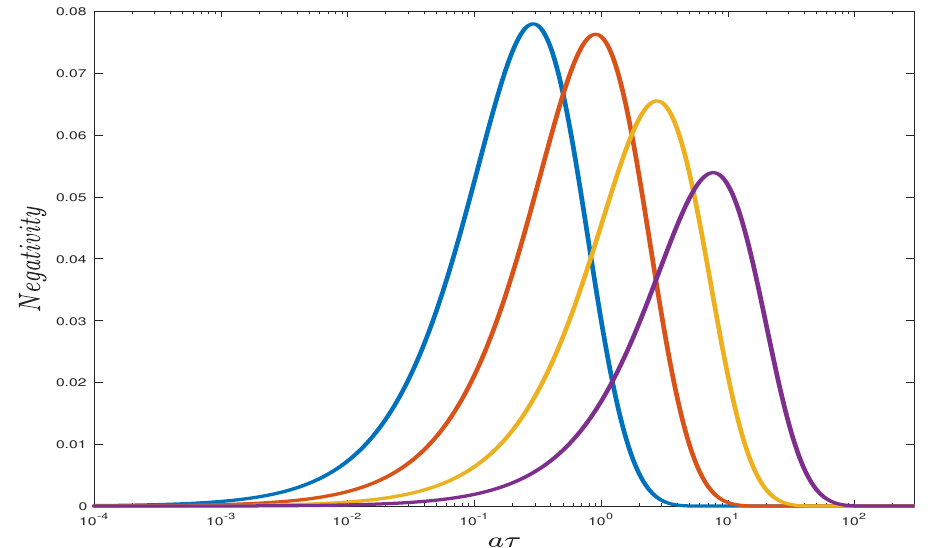
Figure 7 . Entanglement evolutionary process over time. Blue, red, yellow and purple lines stand for D = 3 , D = 4 , D = 5 , D = 6 , respectively.